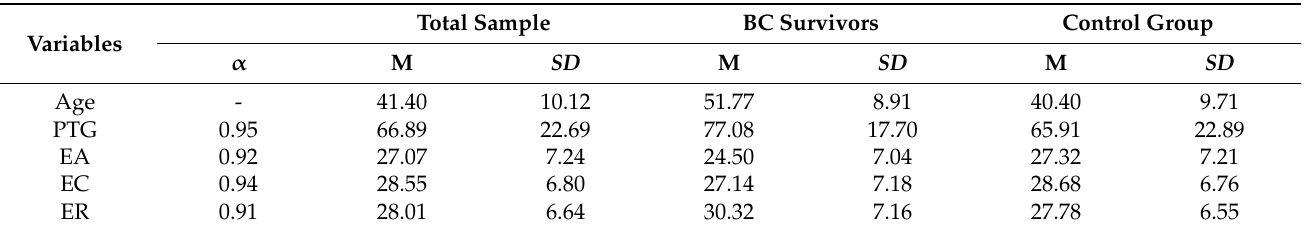
Table 1. Internal Consistencies and descriptive statistics of the total sample, and for the breast cancer survivors and control group.